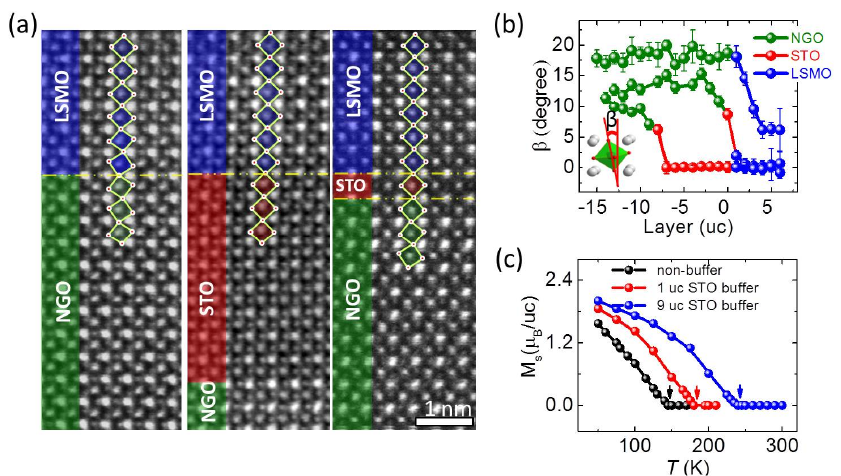
Figure 11. ( a ) Inversed annular bright-field STEM images of ( left panel) LSMO/NdGaO 3 (LSMO/NGO), ( middle panel) LSMO/STO (9 u.c.)/NGO and ( right panel) LSMO/STO (1 u.c.)/NGO heterostructures. The connectivity of oxygen octahedra across the interfaces is indicated. ( b ), Layer-position dependent mean octahedral tilt angle (β), together with their standard deviation in LSMO/NGO heterostructures with and without a STO buffer layer. The data for non-buffered sample is shifted upward by 6° for clarity. ( c ) The temperature-dependent saturated magnetization for buffered and non-STO-buffered LSMO films. All the LSMO films are 6 u.c. thick. Reproduced with permission from Liao et al [40]. Copyright 2017 John Wiley and Sons.